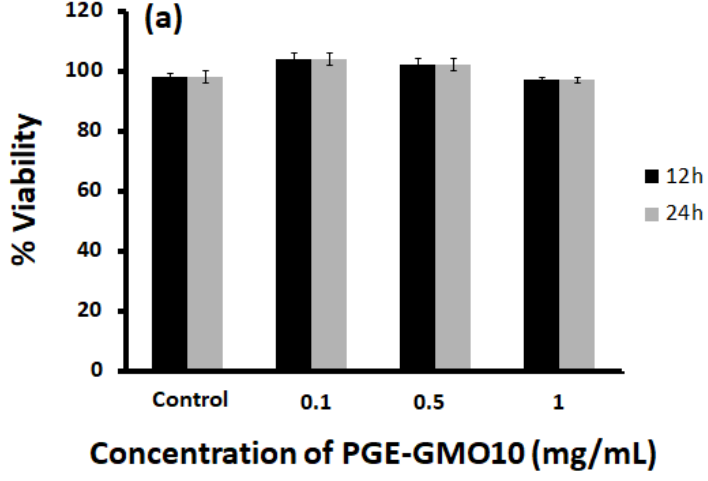
Table 4. Effect of PEG-GMO10 formulation on DNA damage in HaCaT cells estimated with the comet assay.